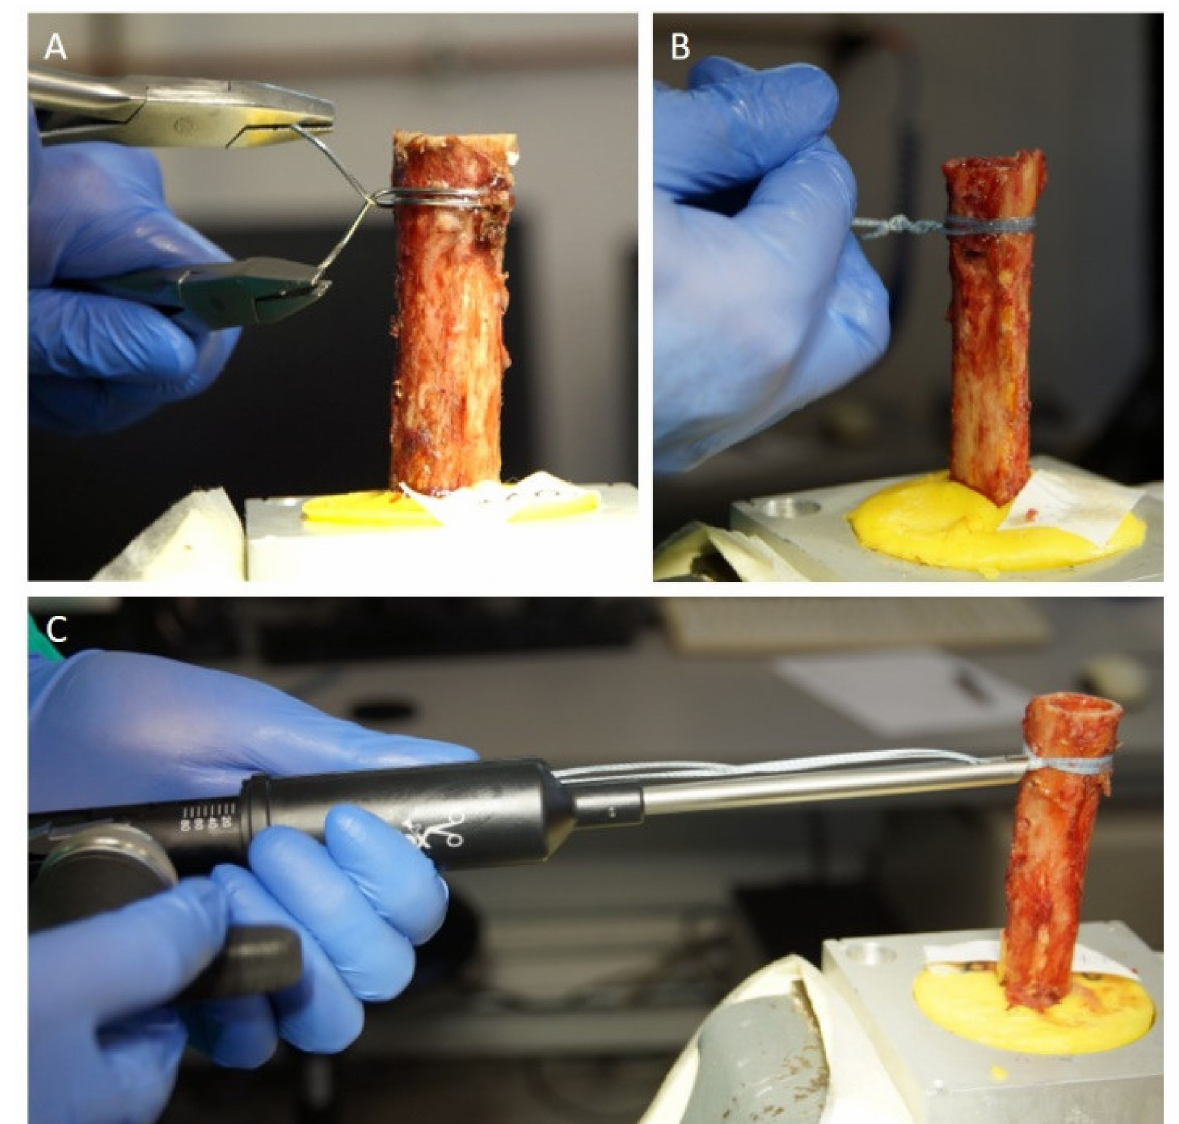
Figure 2. ( A ): Application of the 1.5 mm steel cerclage wire in group 1 (steel wire). ( B ): Hand-knotting of the FiberTape cerclage in group 3 (FT-hand). ( C ): Tensioning of the FiberTape cerclage system in group 2